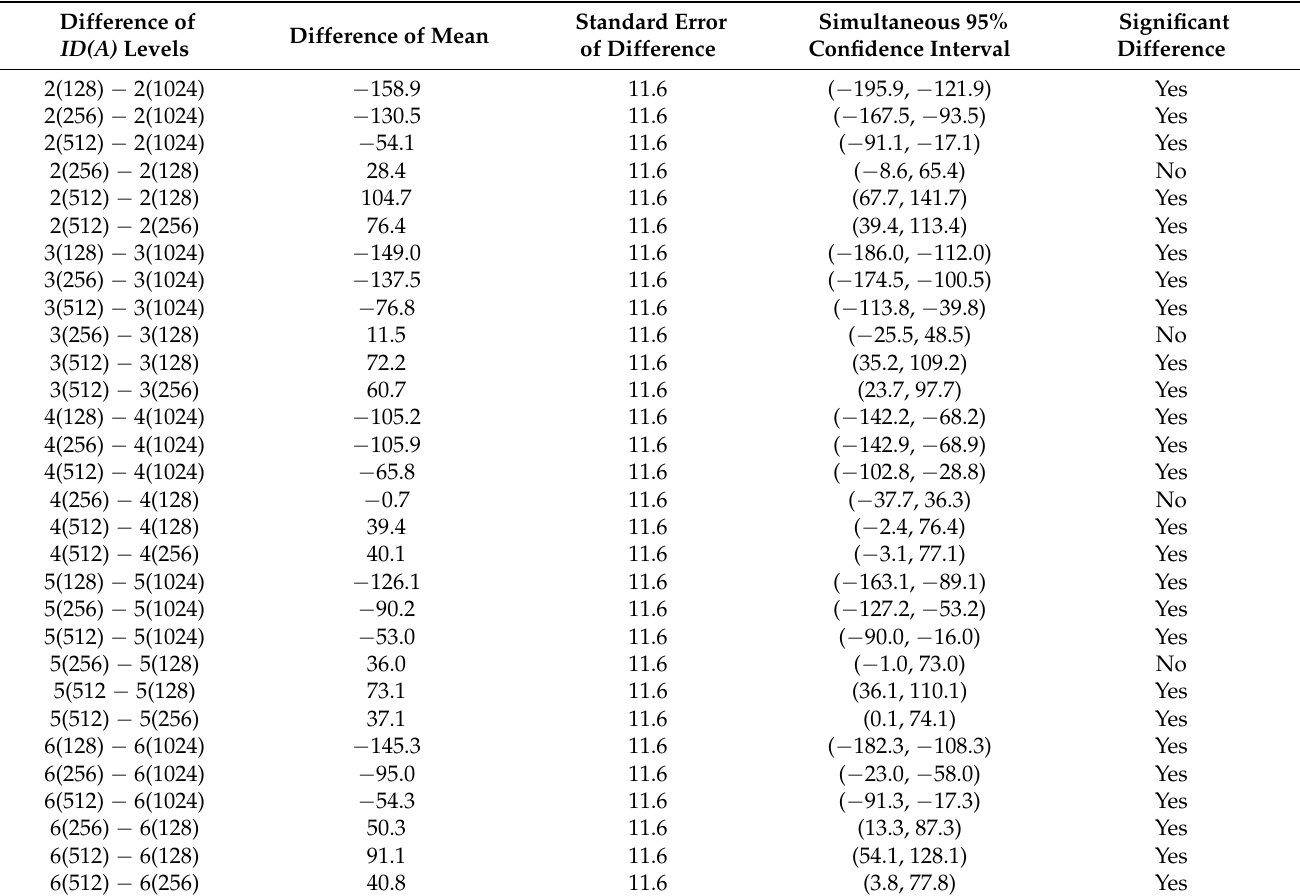
Table 5. Dunn-Šid á k simultaneous test for the planned contrasts, indicating that most of the tasks with the same ID do not have identical MT